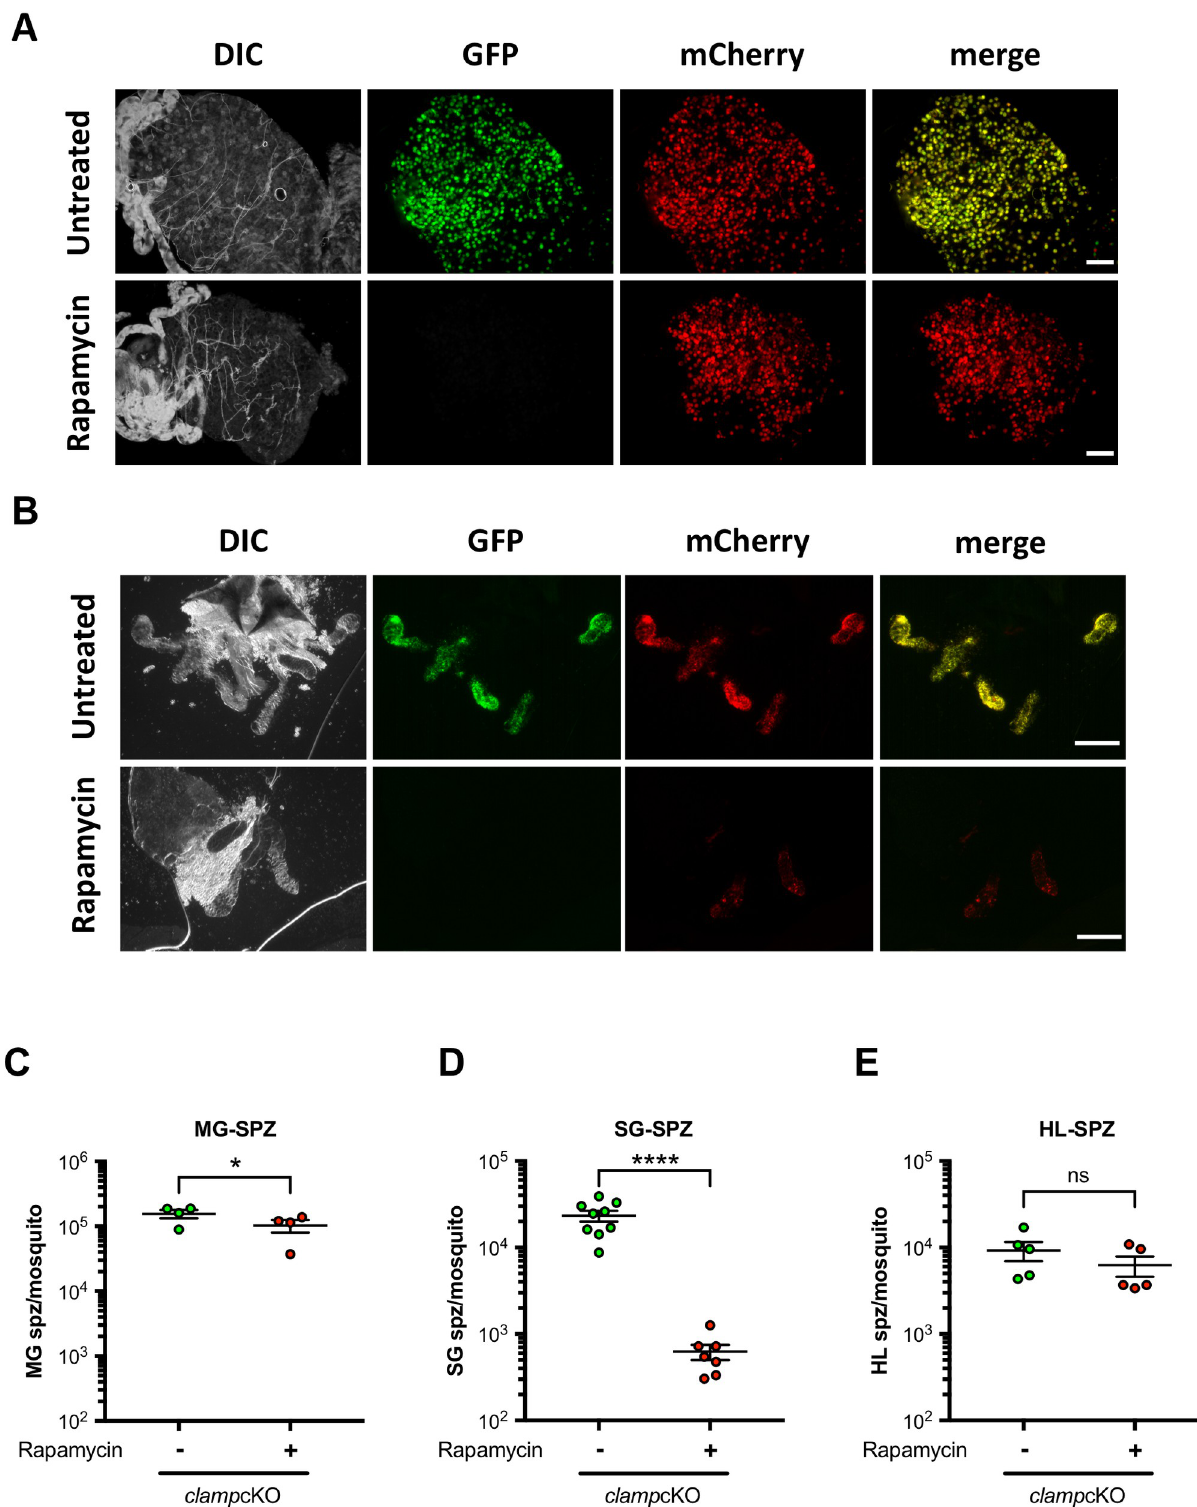
Fig 2. Deletion of clamp impacts invasion of mosquito salivary glands by sporozoites. A-B. Fluorescence microscopy imaging of midguts (A) and salivary glands (B) from rapamycin-exposed and untreated clamp cKO-infected mosquitoes, dissected at day 16 or 21 post-feeding, respectively. Exposure time and contrast were adjusted at the same level for each channel in both conditions. Scale bar, 200 μ m. C-E. Comparison of sporozoite